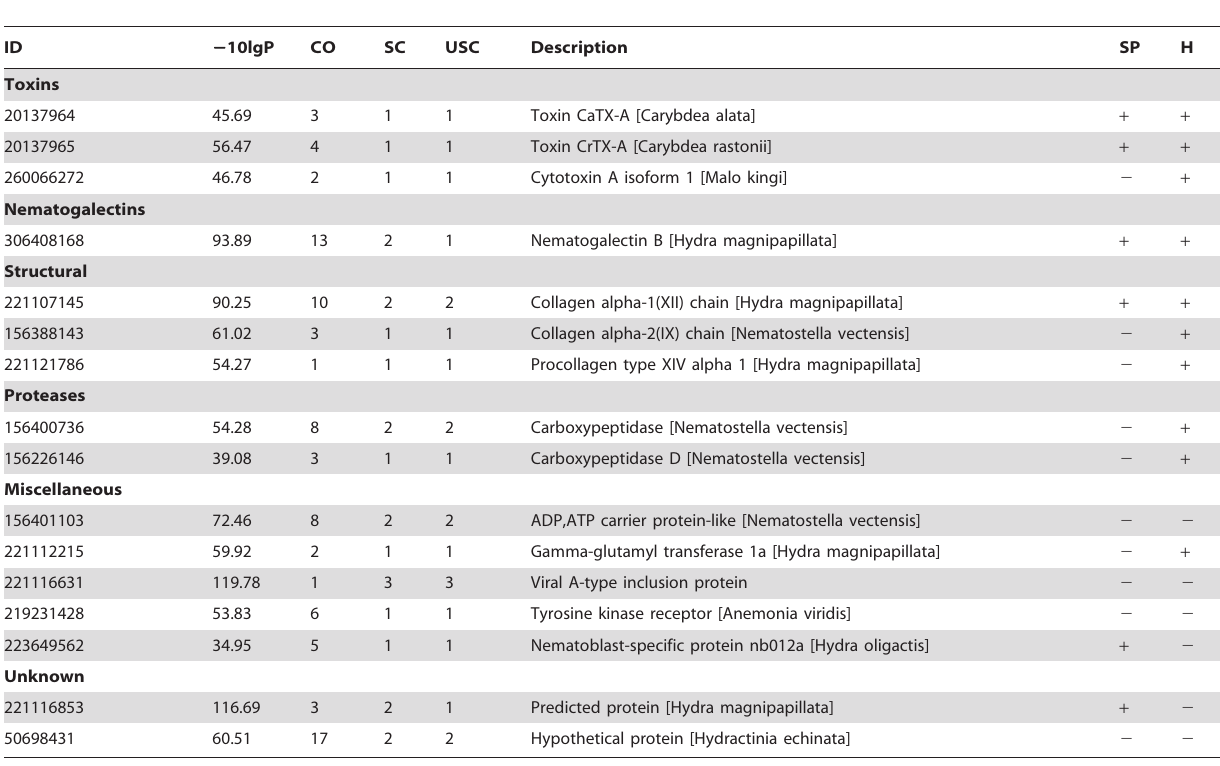
Table 2. Additional proteins identified using a homology search of de novo sequence tags in PEAKS.